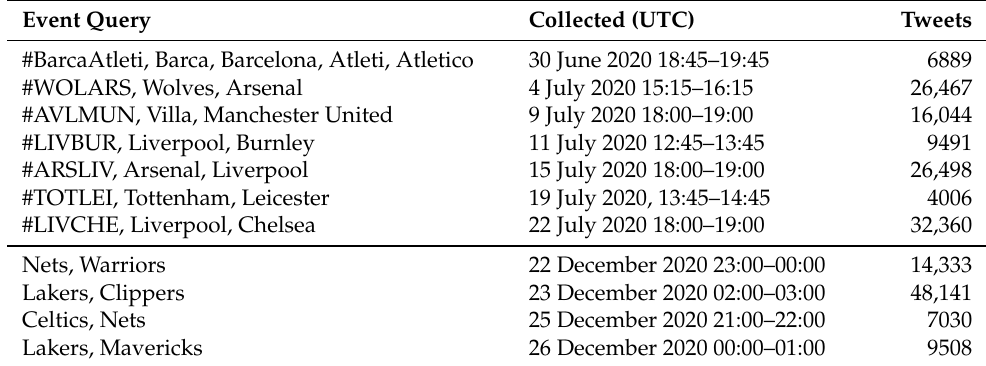
Table 1. The datasets used in the